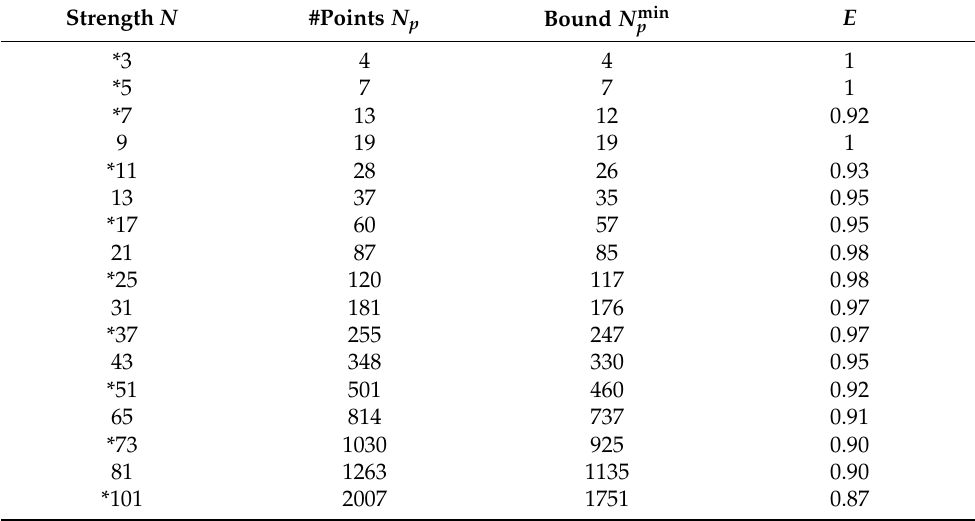
Table A1. Characteristics of the triangle quadrature rules used in our algorithms. All those rules were constructed with the program PolyQuad (accessed on 23 September 2022) (https://github.com/ PyFR/Polyquad) by Witherden and Vincent [62]. Stars near strengths identify the rules that are used in the finite precision algorithm. The bound N min p (third column) is the empirically proposed bound on the number of points, N min p (fourth column) is the “efficiency”, defined as: E = N min p / N p . Efficient quadrature rules have E